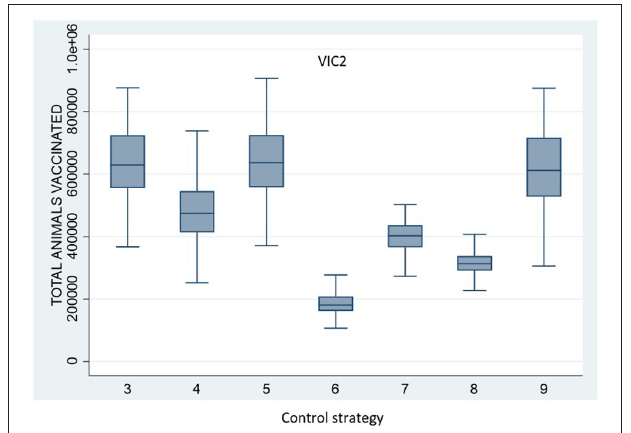
FIGURE 5 | Boxplots of the total number of vaccinated animals for Scenario VIC3 for the control strategies with vaccination (Control Strategy 3 to